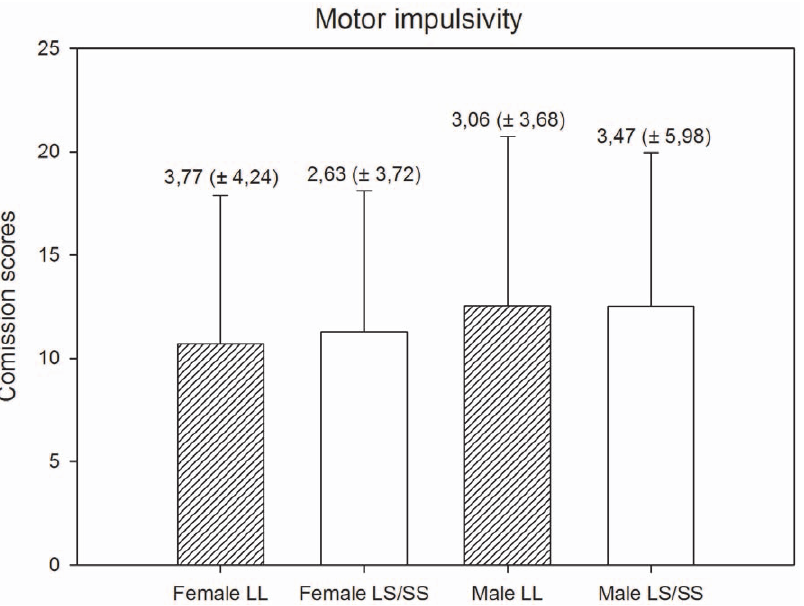
Figure 2. Motor impulsivity scores and standard deviation of scores by gender and genotype.